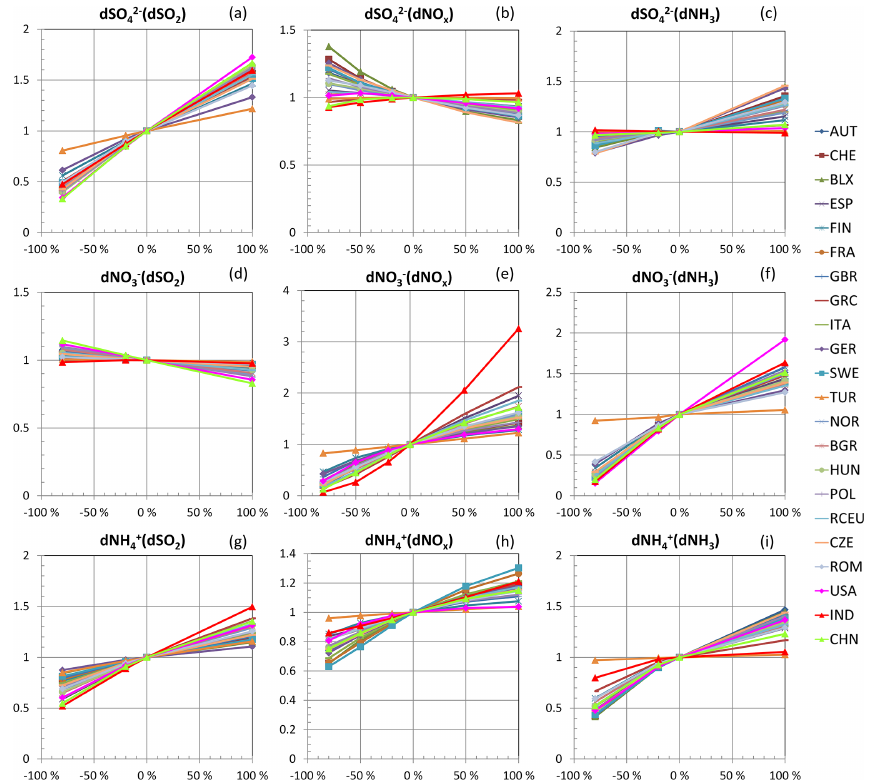
Figure 3. TM5 CTM change in population-weighted regional mean secondary PM 2 . 5 components SO 2 − relative to their respective base scenario concentration, as a function of precursor SO 2 (a, d, g) , NO x (b, e, h) , and NH 3 (c, f, i) emission perturbation strength for European receptor regions, the USA, India, and China. Perturbations were applied over all European regions